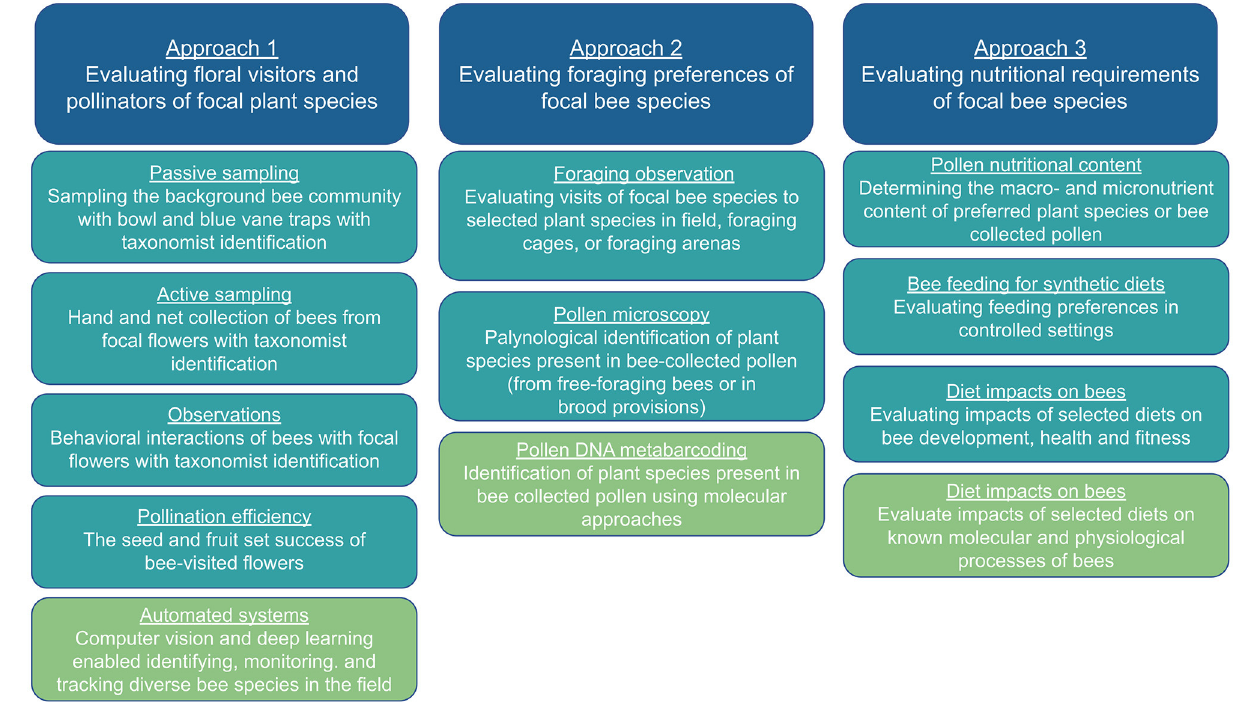
FIGURE 1 | An outline of each research approach in bee nutritional ecology and their main